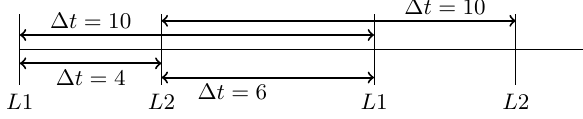
Figure 3: Schematic schedule of two subway lines L1 and L2 separates the subway platform. Pedestrians as well as vehicles on the side road have the possibility to trigger the traffic light. The length of the traffic light’s green phases for the side road varies between 8 and 20 seconds depending on whether a pedestrian,